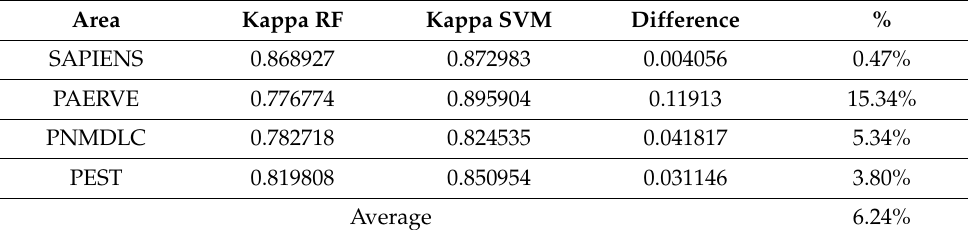
Table 7. Classifier performance comparison.